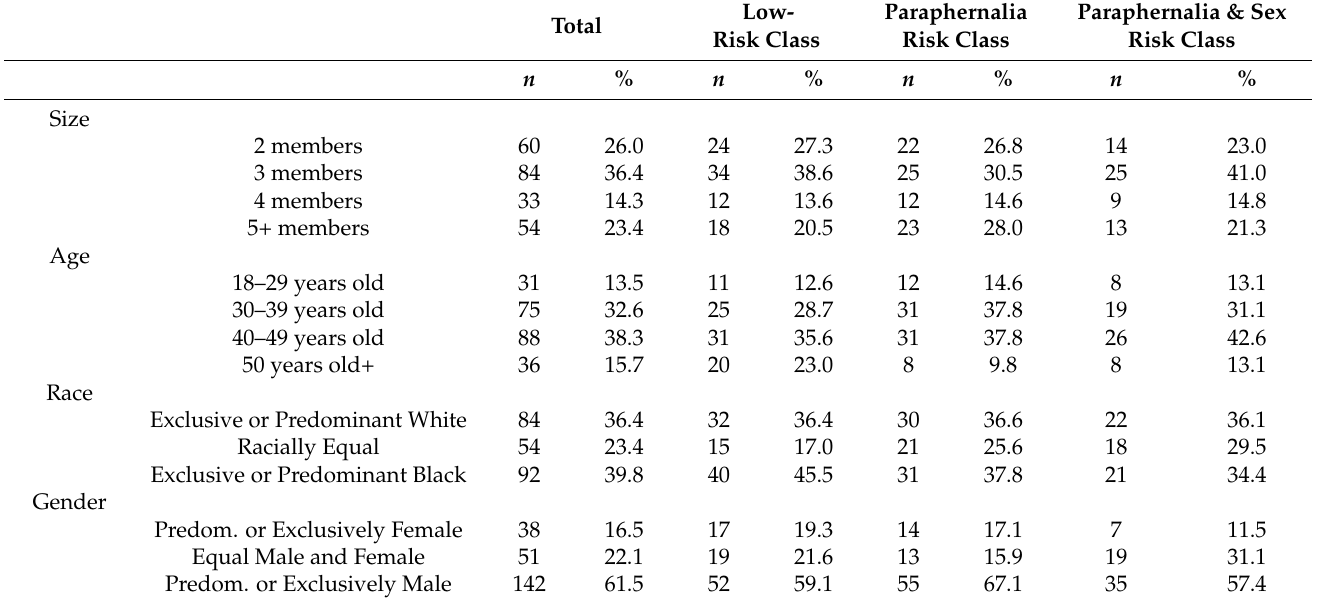
Table 2. Demographic characteristics of networks ( n = 231 *) by latent class.